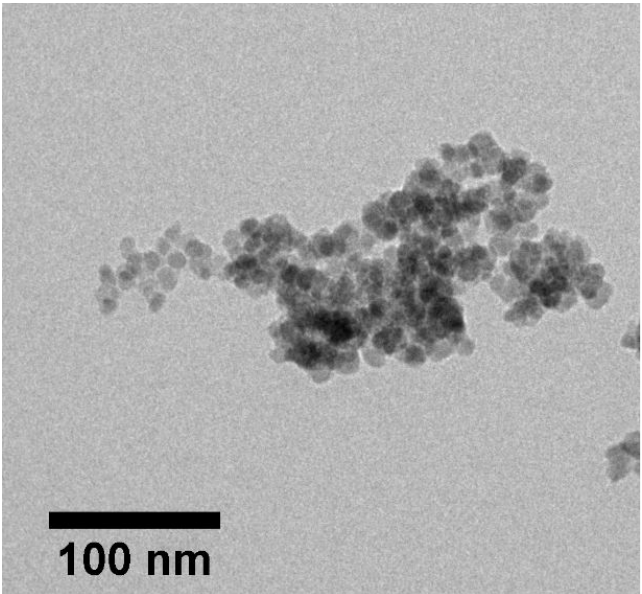
Figure A1. Brightfield TEM image of SPION-APTES-PepA aggregates after drying. Scalebar is 100 nm.